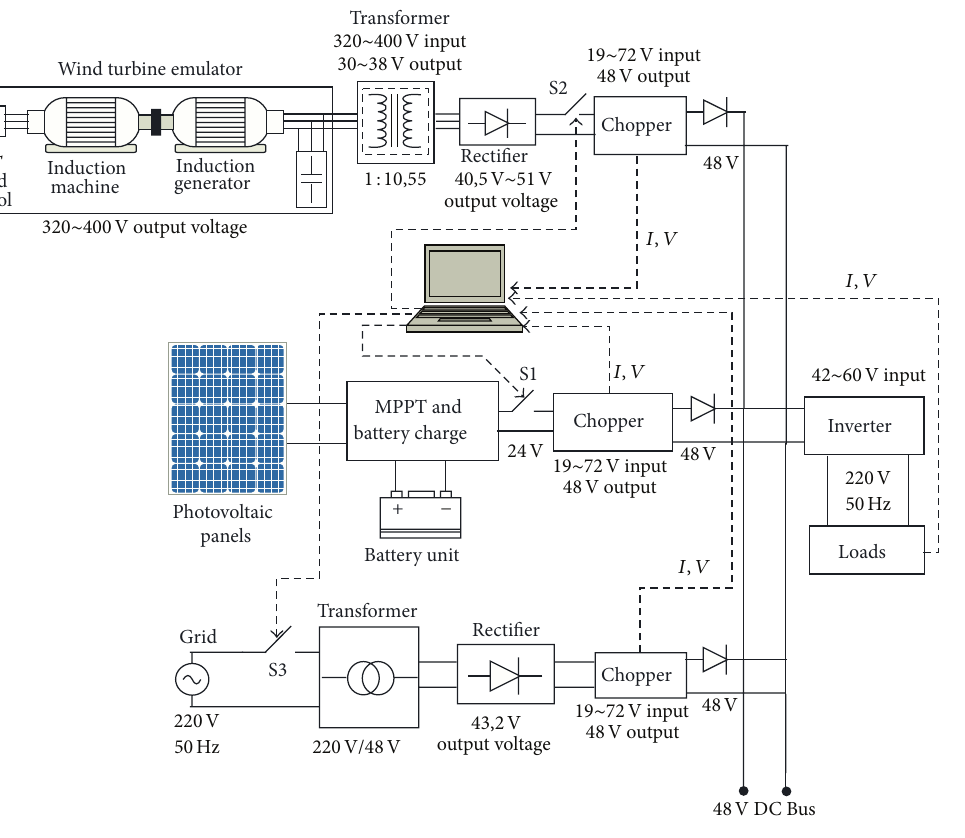
Figure 7: PV solar panels-WES-grid